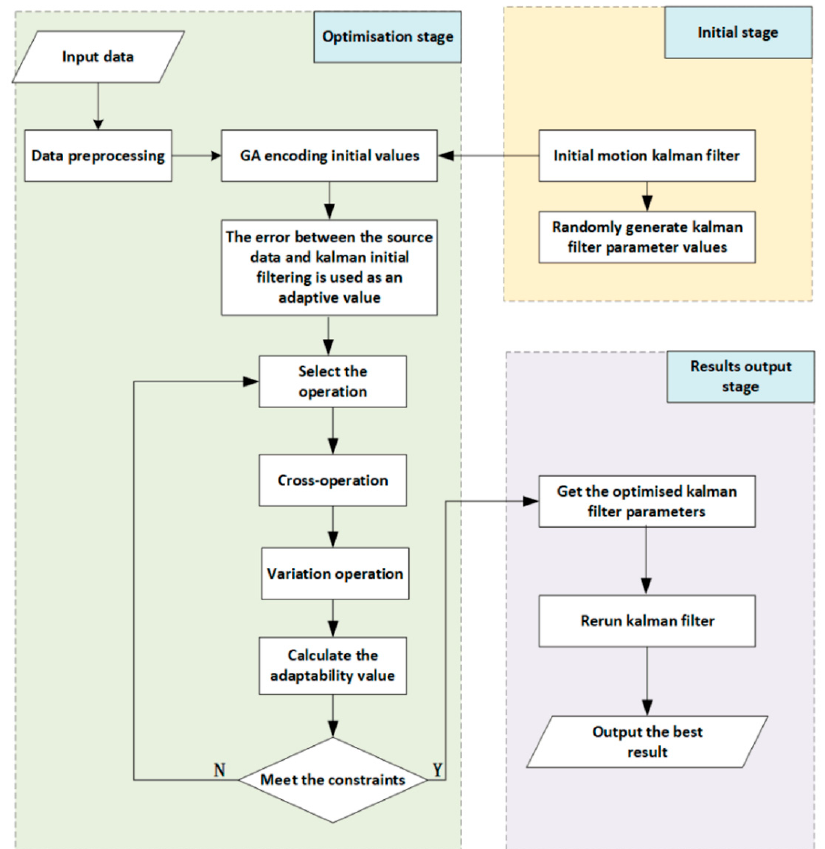
Figure 2. Diagram of the algorithm.